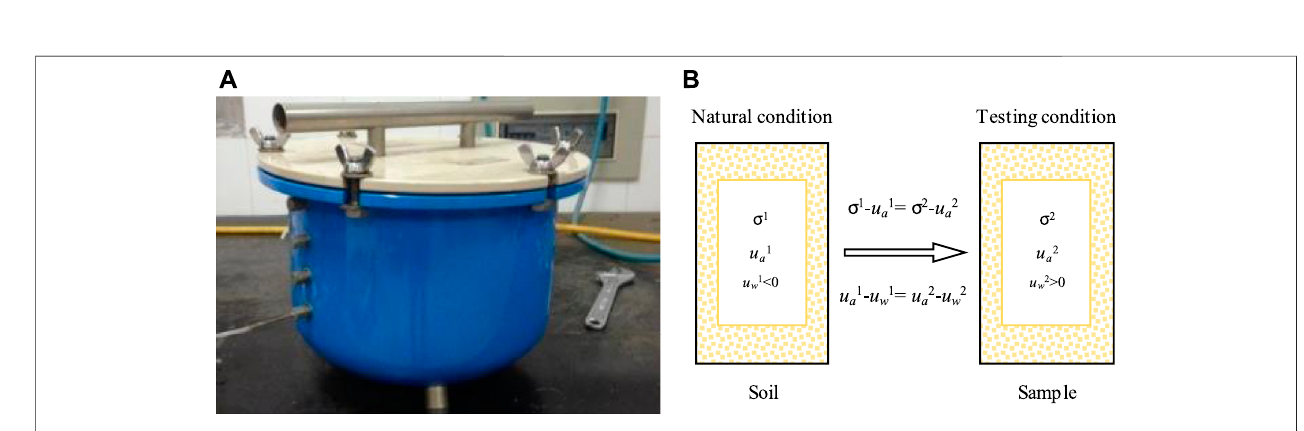
FIGURE 1 | Illustration of (A) pressure plate extractor and (B) its test